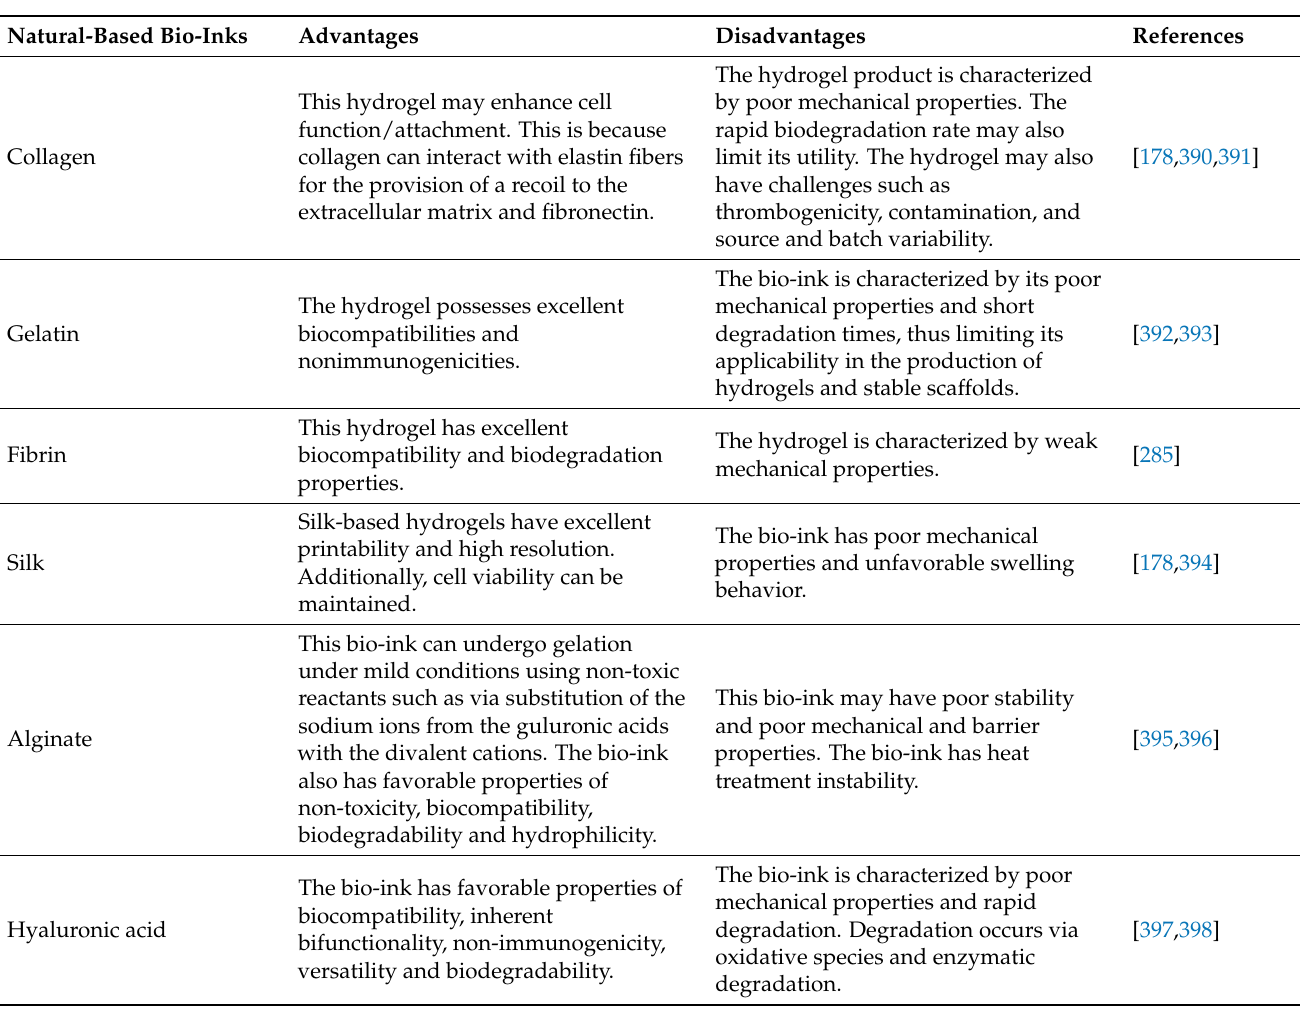
Table 5. Advantages and disadvantages of natural